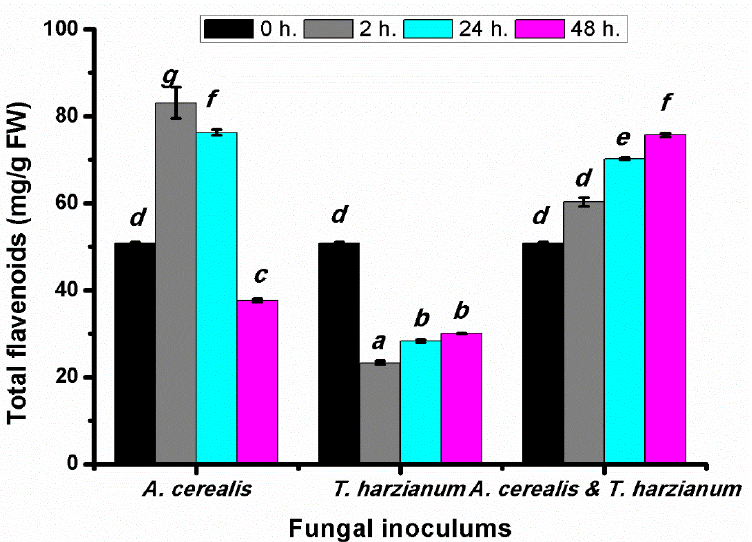
Figure 7. Total flavonoids (mg/g FW) of tomato leaves ( S. lycopersicum L.) under the effect of pathogen ( Alternaria cerealis MT808477), and pathogen inhibitor ( Trichoderma harizainum ) after 0, 2, 24, 48 h of inoculation, data are means ± SD ( n = 3), with statistically significant differences ( p < 0.05).